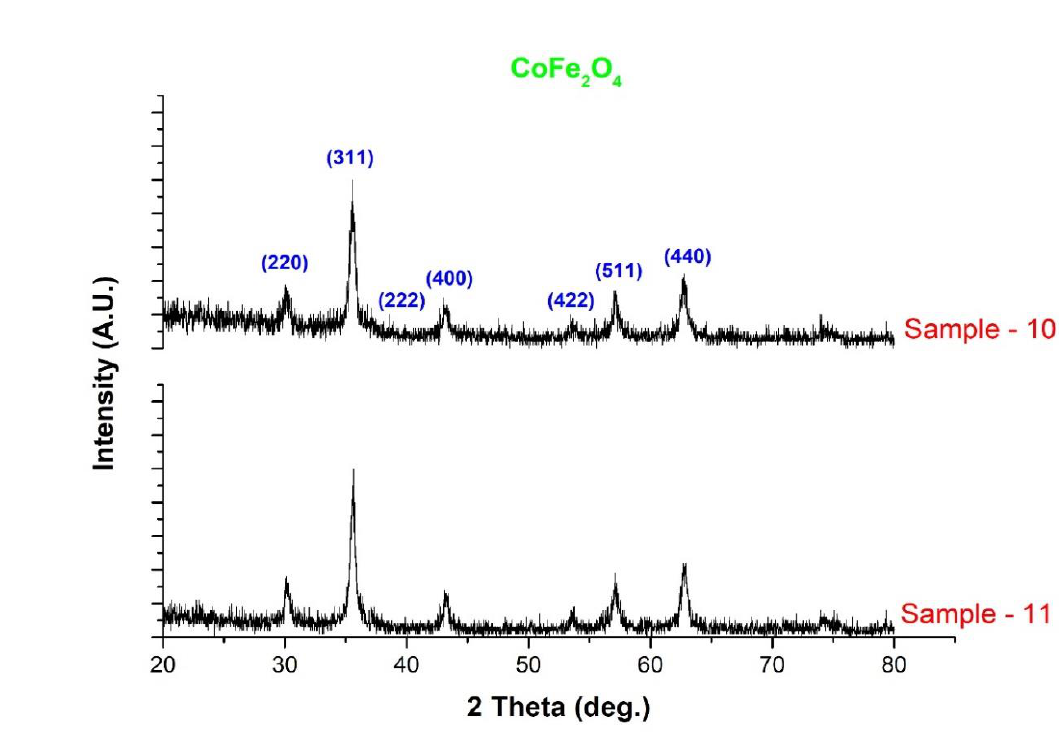
Fig.5-I: XRD pattern of sample – 10 (T=200 o C, t=10h), sample – 11 (T=200 o C, t=